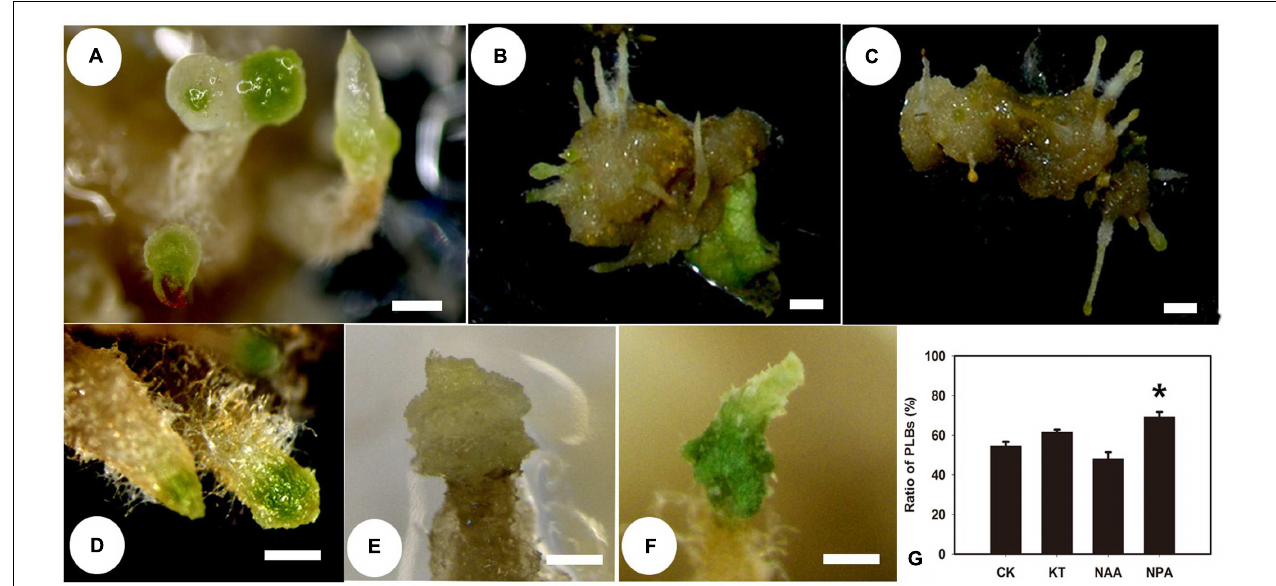
FIGURE 2 | Protocorm-like bodies (PLB) formation is affected by supplementary NAA, KT, and NPA. Rhizoid tips began to swell and turn green after callus-rhizoids were transferred to PIM. This process was defined as PLB formation. The percentage of callus-rhizoids forming PLBs was calculated after culture on PIM for 9 days. (A) PLBs normally formed after 9 days of culture on PIM, and the rhizoid tip swelled and turned green. (B,E) PLB formation was inhibited after culture on PIM supplemented with 1.0 mg/L NAA, but some large white PLBs formed. (C,D,F) PLB formation increased when callus-rhizoids were cultured on PIM containing 0.1 mg/L KT. Rhizoid tips turned green earlier after KT treatment compared with the control. (G) Rate of PLB formation on medium with different PGRs compared with CK. Error bars represent the SE of three biological replicates. Asterisks indicate highly significant differences calculated using the t -test ( ∗ P < 0.05) ( n = 9–12 for each